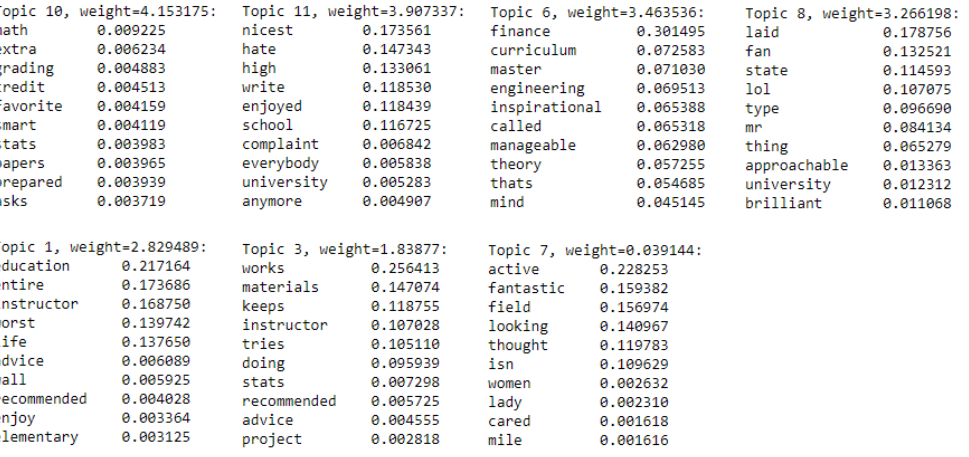
Figure 7. Topics with positive θ -weights. The θ -weight is given as the topic weight. The strength of each word is given numerically beside each of the top 10 words.